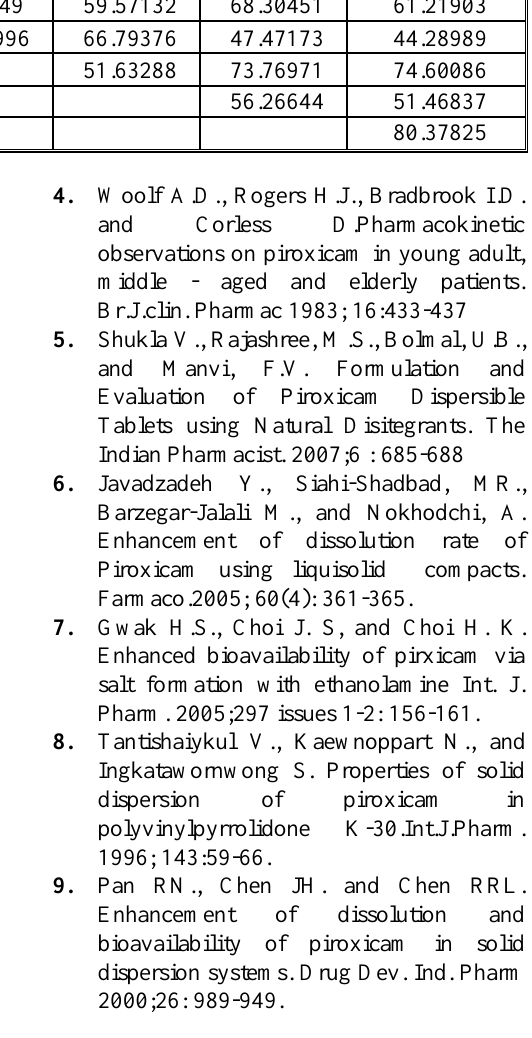
for the release profiles in 0.1 N HCl 2